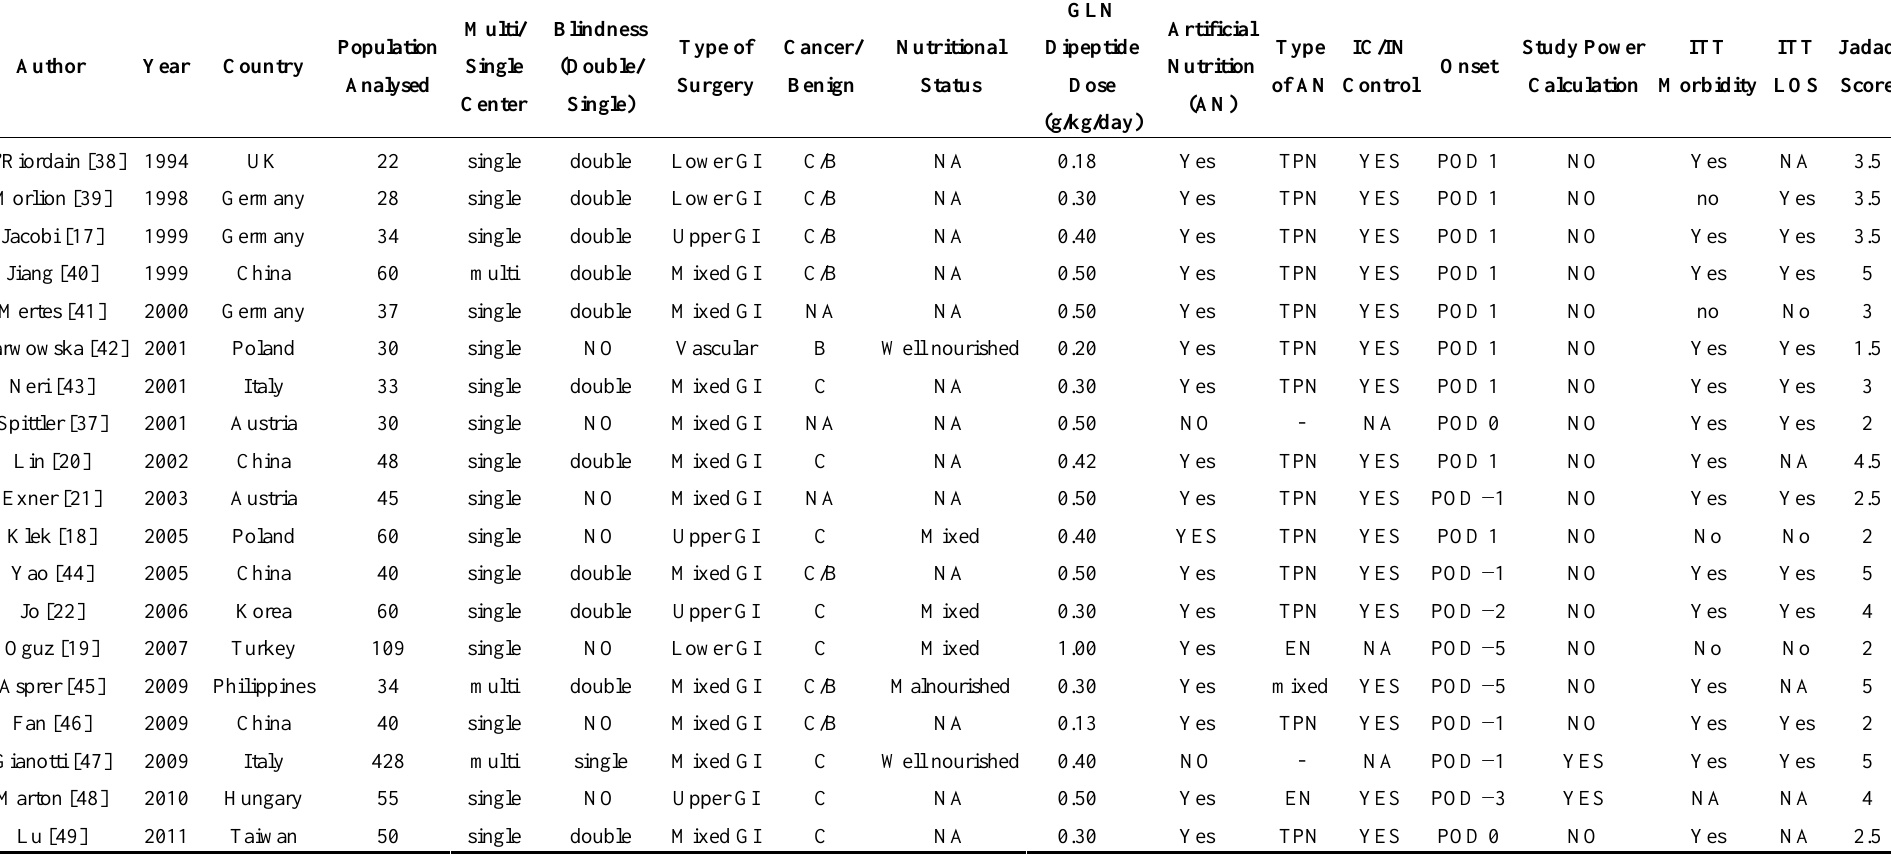
Table 1. Characteristics of the included